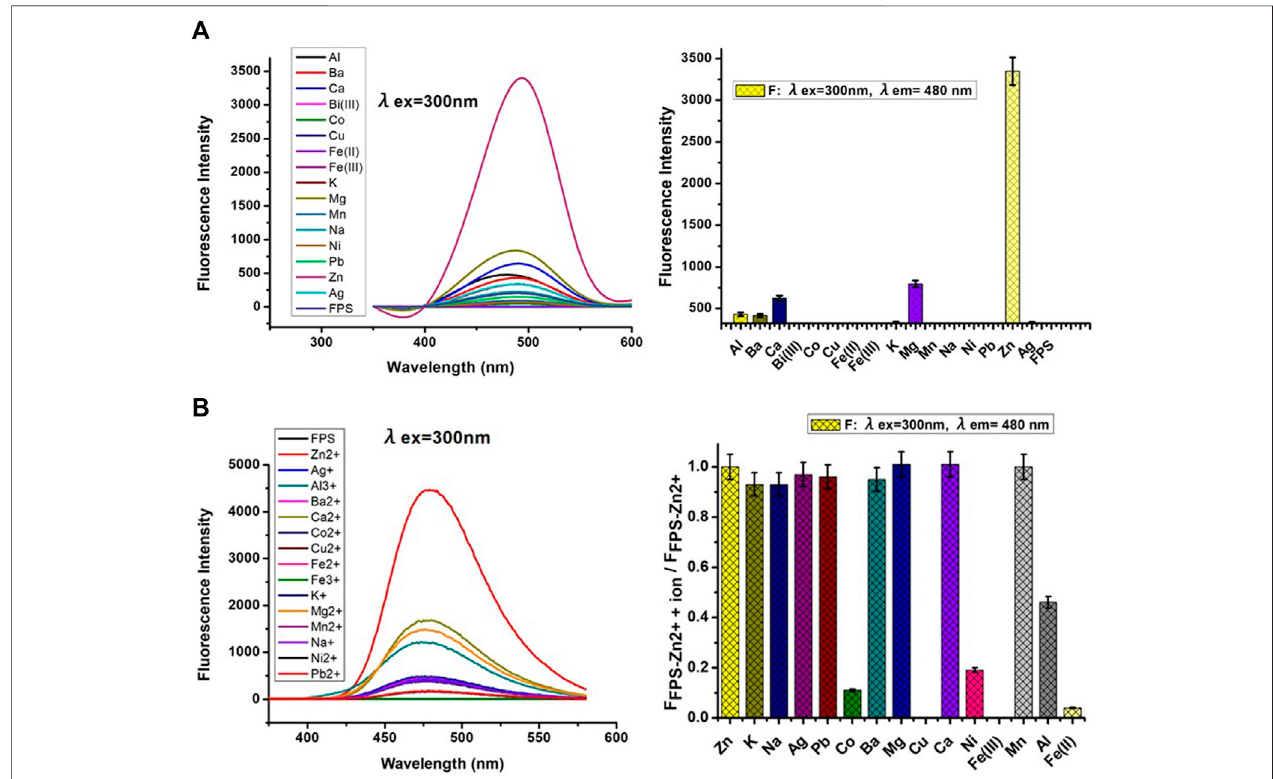
FIGURE 2 | (A) Left: Fluorescent spectra of FPS (5 μ mol/L) with various metal ions (10.0 equiv.) in methanol; Right: Dense bars indicate the fl uorescence intensity ( λ ex (cid:2) 300nm, λ em (cid:2) 480 nm) (B) Left:FluorescentspectraofFPS(5 μ mol/L)+10.0equiv.Zn 2+ withvariousmetalions(10.0equiv.)inmethanol;Right:Densebarportion indicates the fl uorescence intensity ( λ ex (cid:2) 300 nm, λ em (cid:2) 480 nm) in methanol solution, respectively.